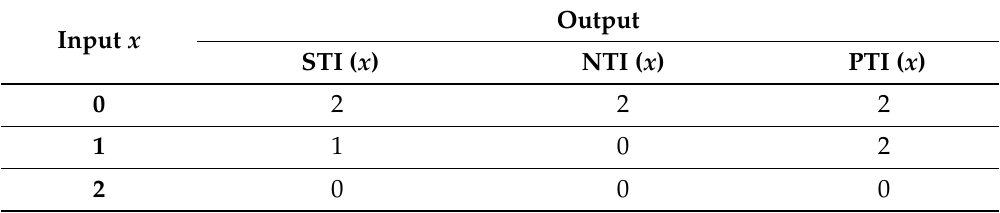
Table 1. Ternary inverters truth